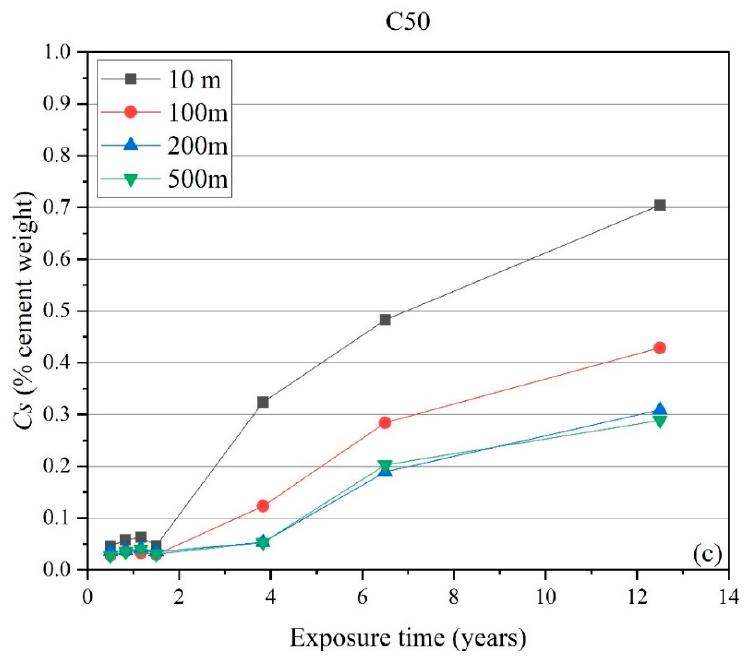
Figure 7. Relationship between Cs and exposure time for C65 ( a ), C57 ( b ) and C50 ( c ) concrete.